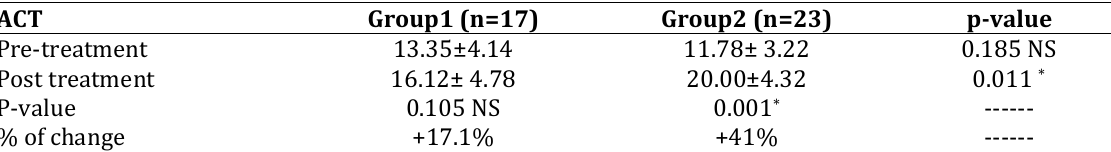
Table III. comparison between the effect of standard asthma treatment alone and in combination with supplement of curcumin on ACT in the end of